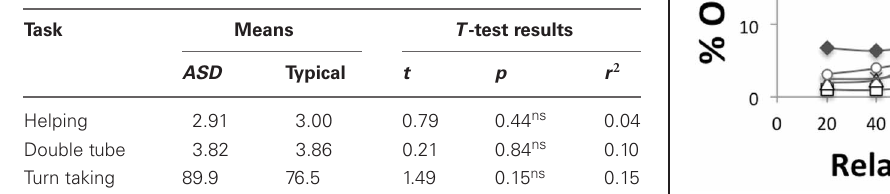
FIGURE 2 | Distributions of relative phase for the five imitation